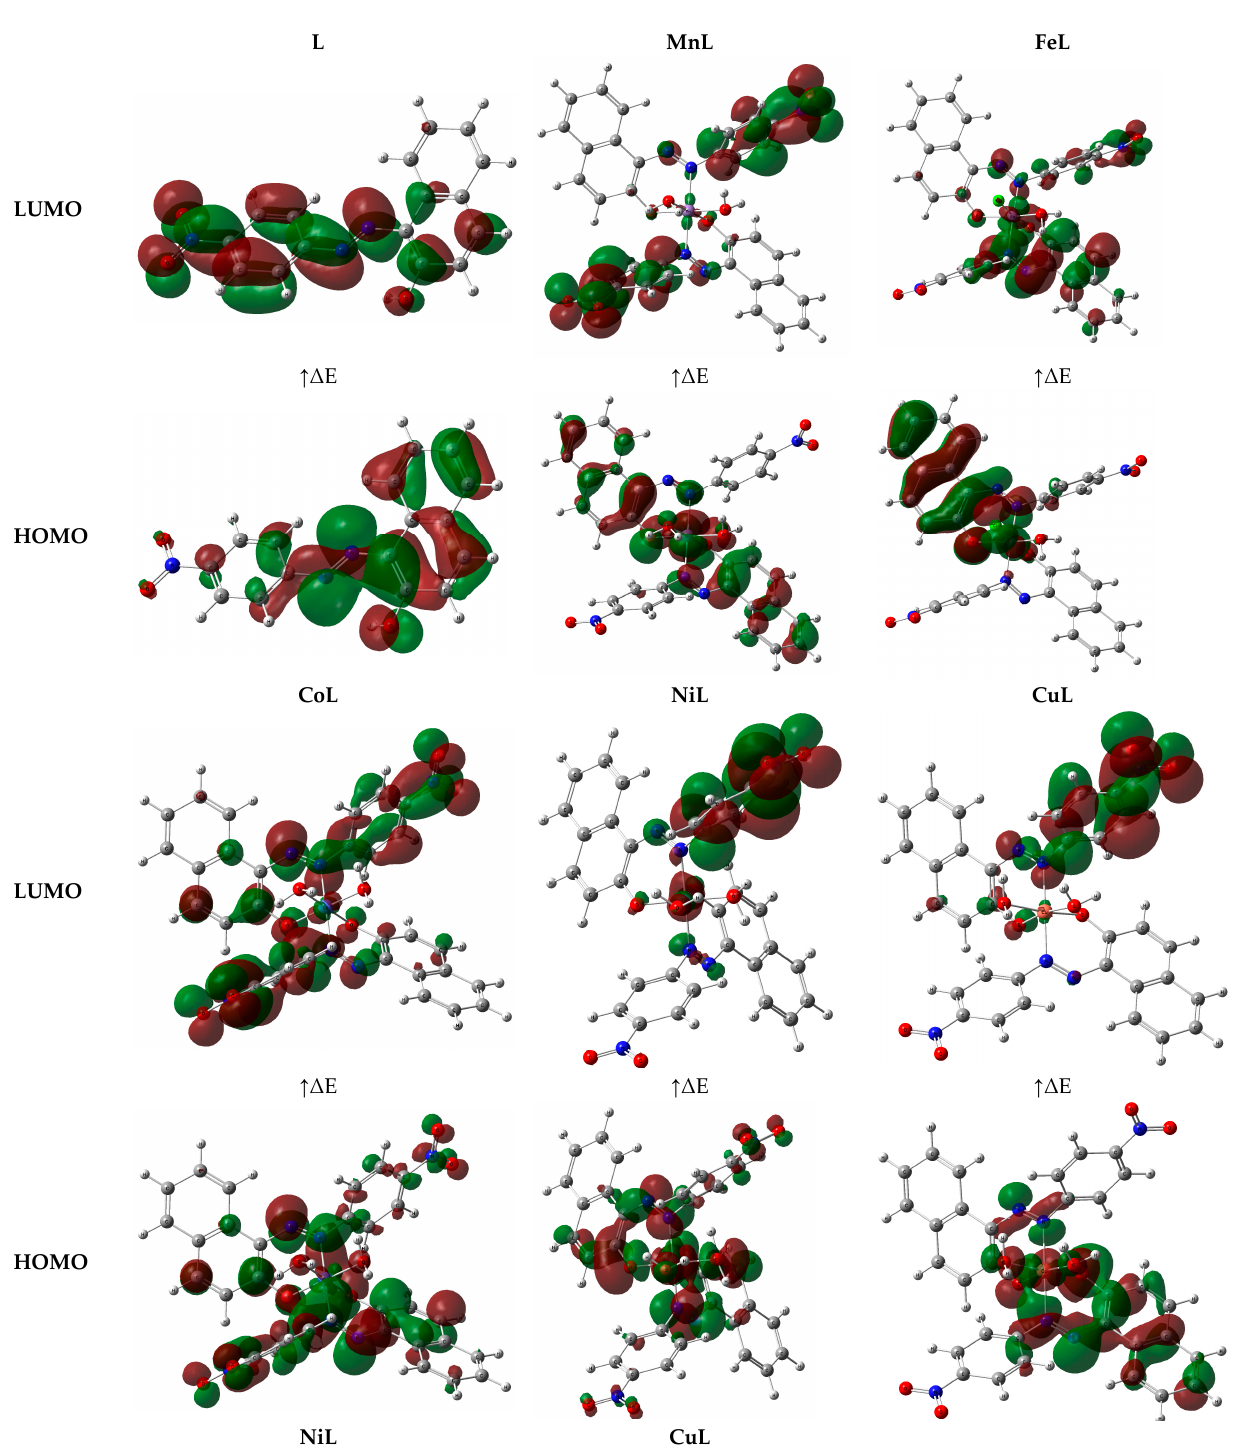
Figure 3. HOMO—LUMO of the optimized structures. The HOMO-LUMO energies are many-sided because of their potential application to understanding molecules’ chemical reactivity, kinetic stability, hardness-softness, biological properties, and polarizability. The HOMO was the most distant electron-containing orbital and hence the most generous giver of electrons. The lowest unoccupied molecular orbital (LUMO) functioned as an electron acceptor. Since the HOMO and LUMO orbitals define the molecule’s stability, they also define its susceptibility to attack by nucleophiles